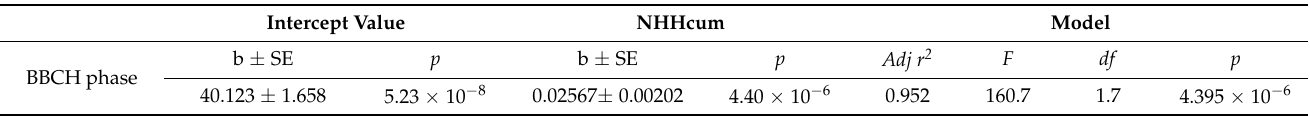
Table 5. Regression model for BBCH built on median values derived from the training set (n = 896 observations on 64 sites). SE = Standard error, b = parameter.